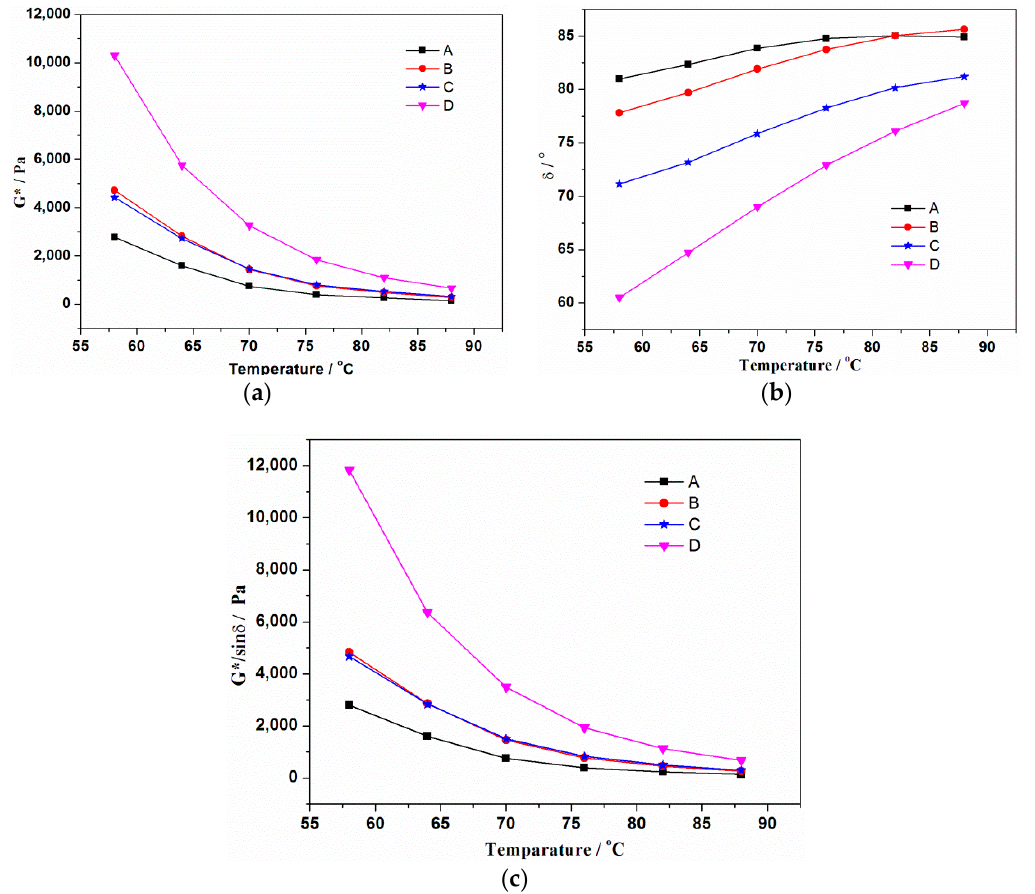
Figure 6. ( a ) G*, ( b ) δ and G*/sin δ , ( c ) of asphalt binders.